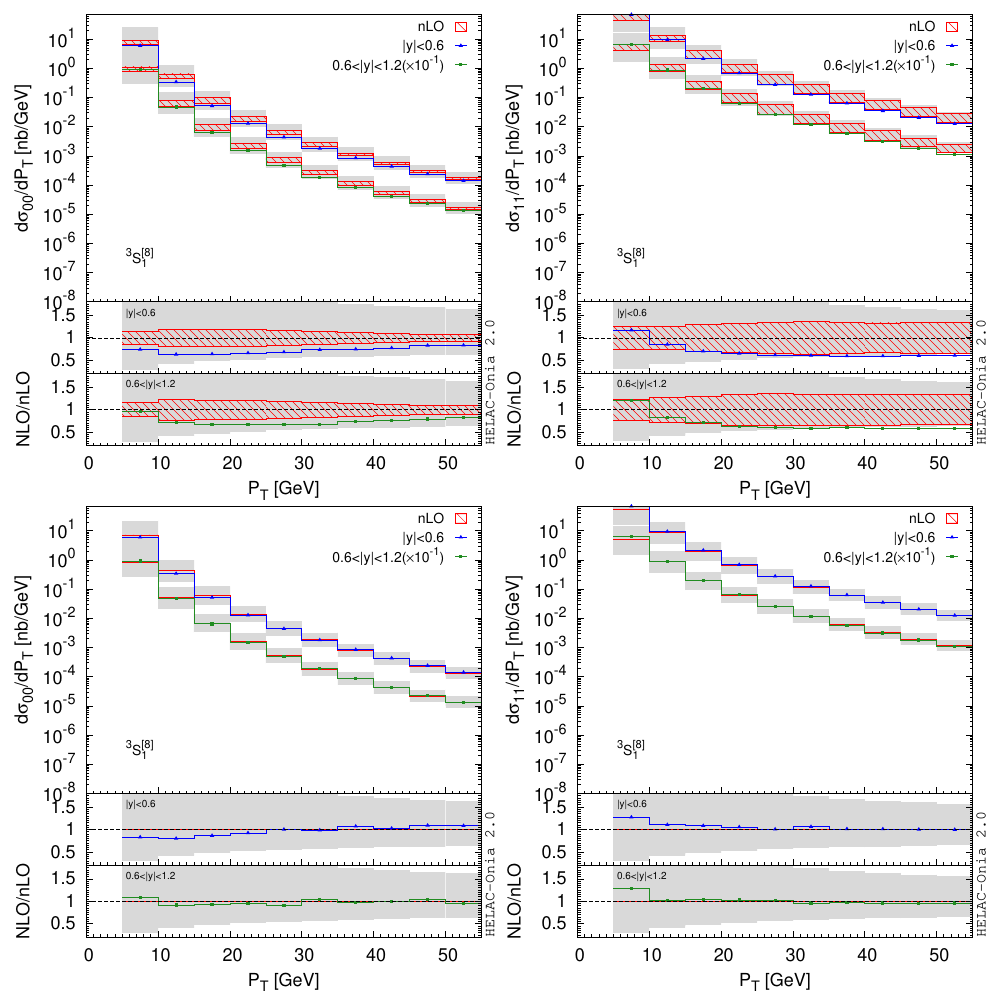
Figure 7 . Comparisons of spin-dependent differential cross sections for the Fock state 3 S [8] nLO (up), tunned nLO with z